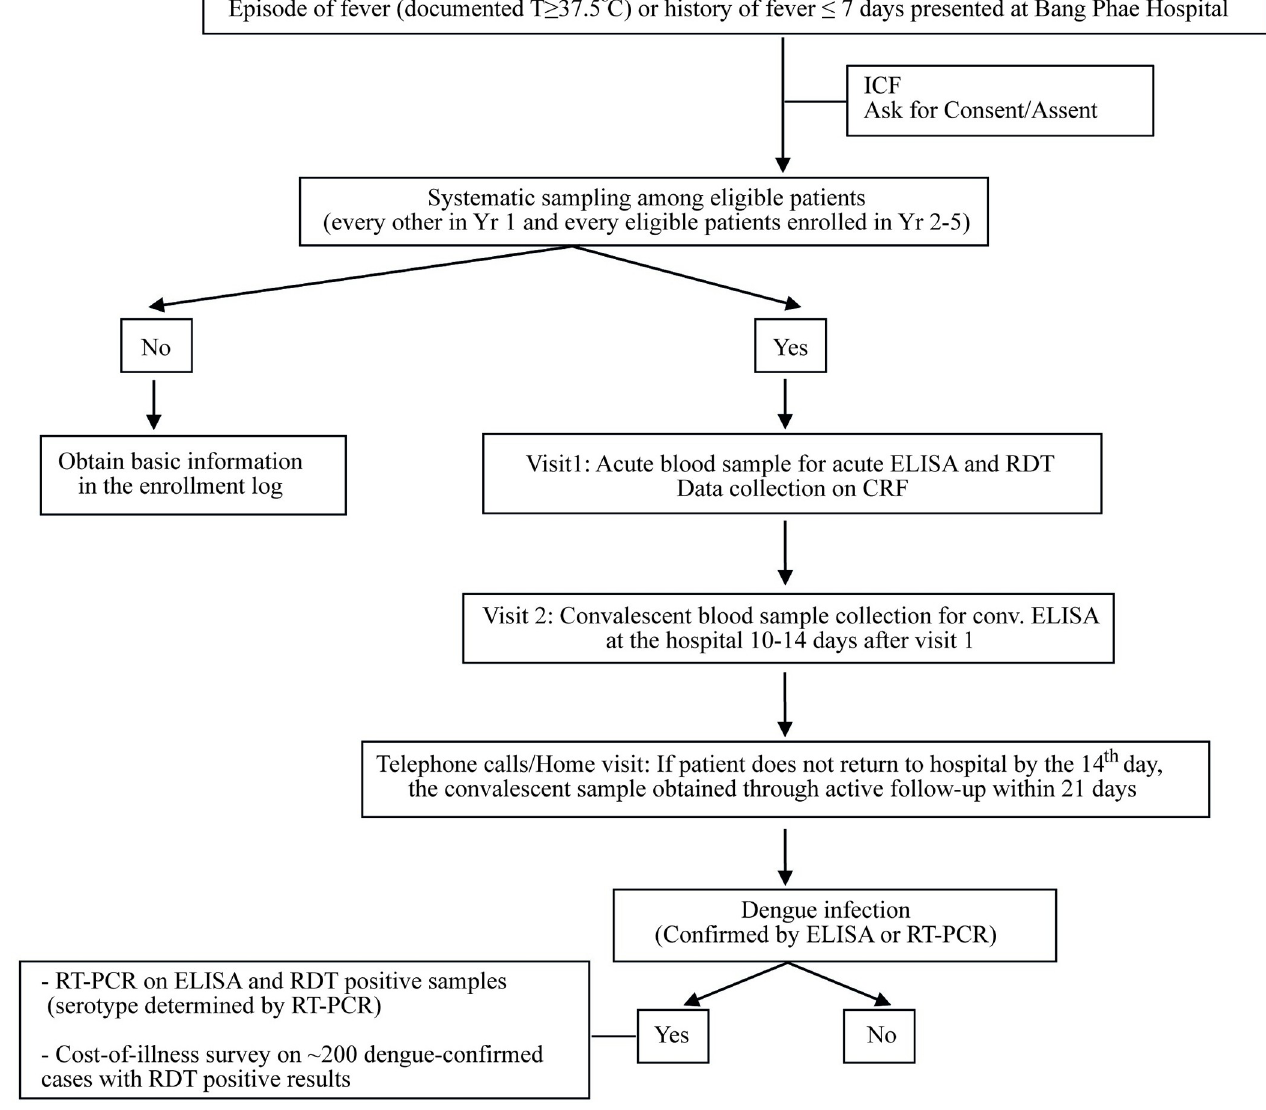
Fig 2. Passive fever surveillance algorithm at Bang Phae Community Hospital. Algorithm showing the design and flow of the passive fever surveillance.